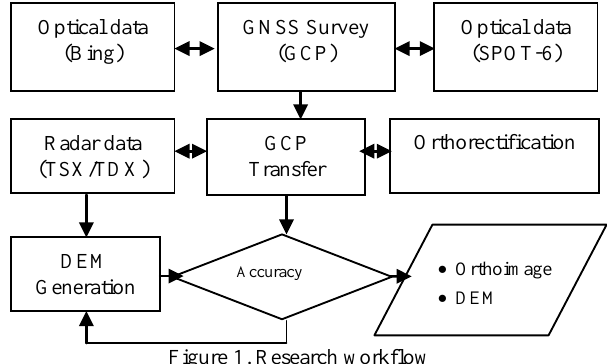
Figure 1. Research workflow